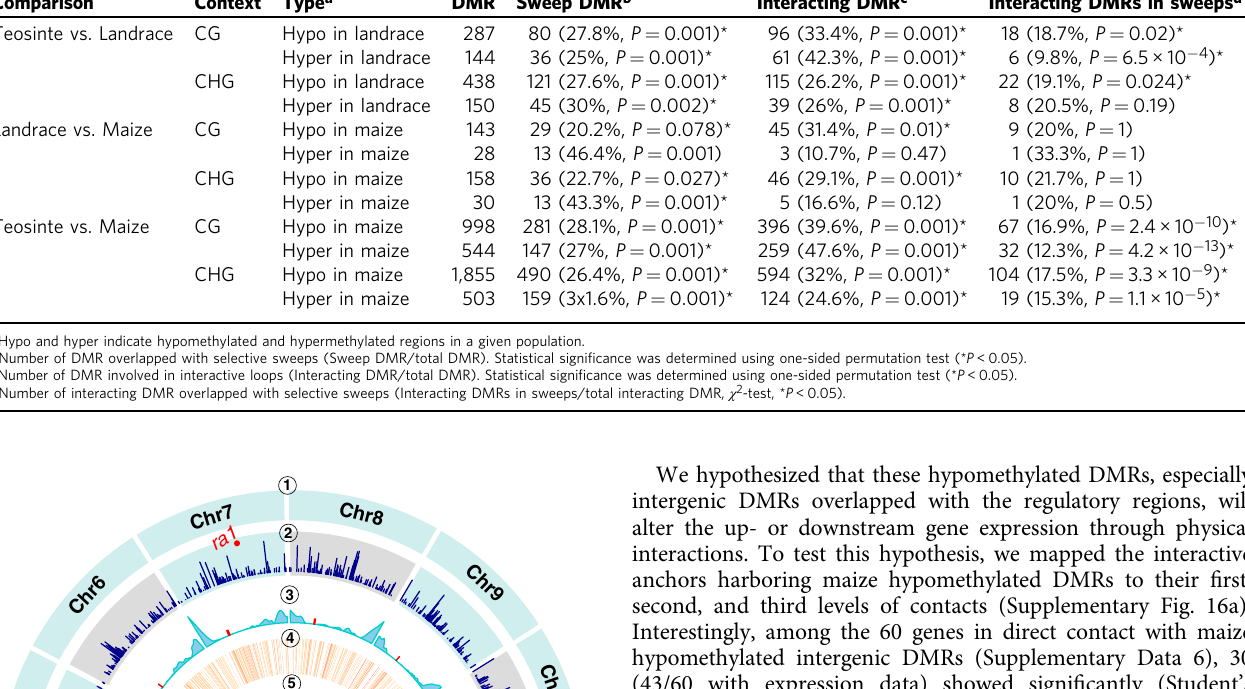
Table 1 Number of differentially methylated regions broken down by context and type. Comparison